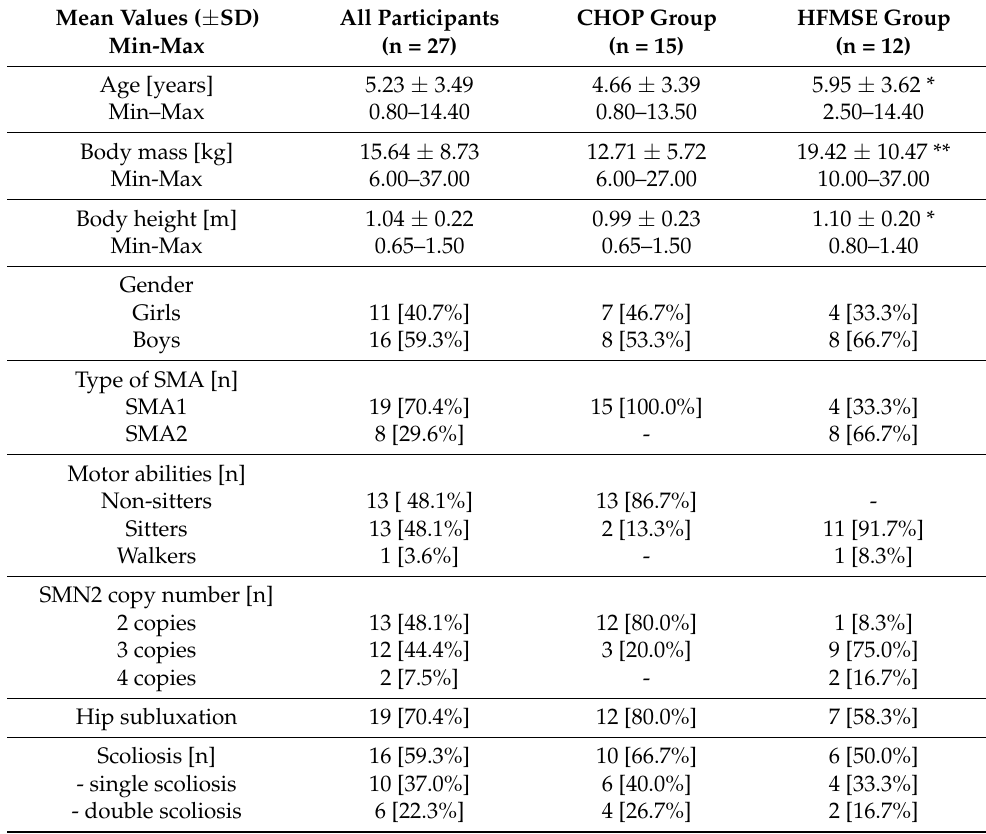
Table 1. Characteristics of